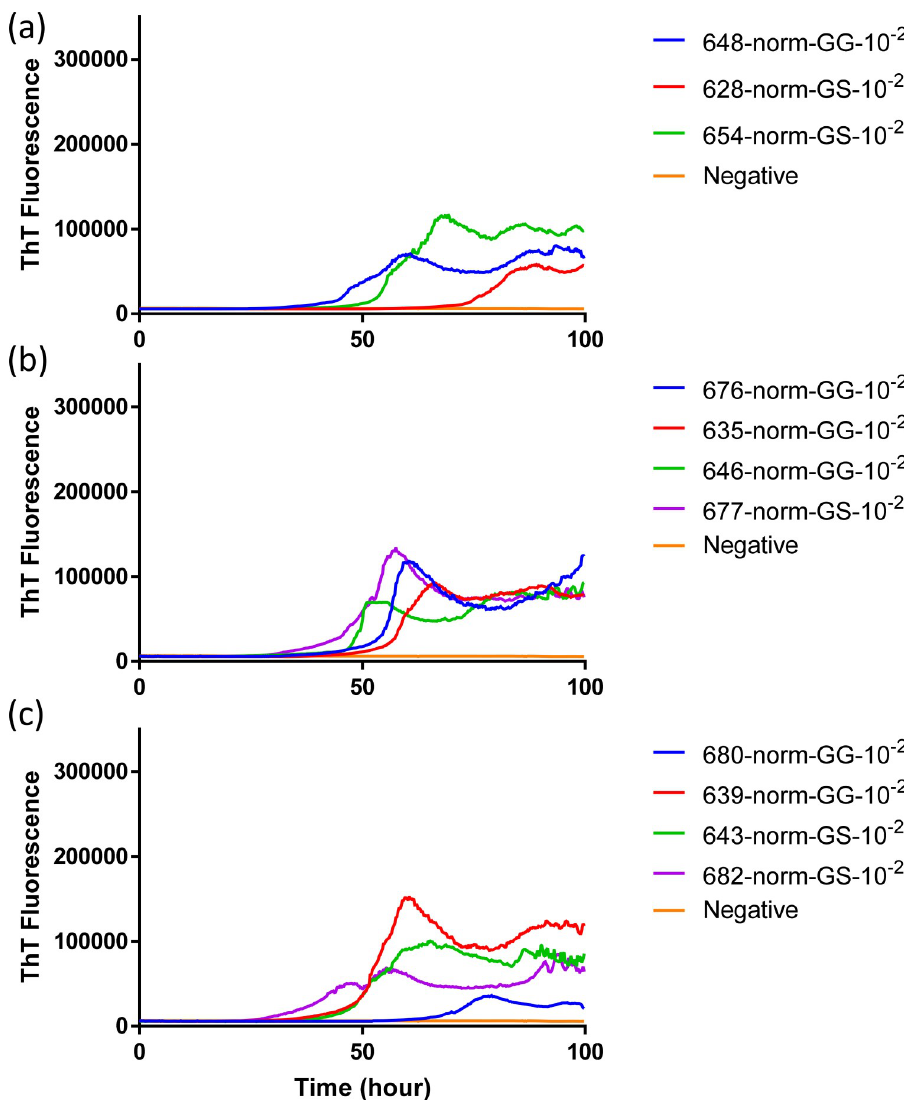
Fig 5. Comparison of seeding activity of RT-QuIC reactions with human rPrP which contain brain seeds from WTD inoculated with brains of infected white-tailed deer (a), elk (b) or mule deer (c) in the presence of 0.001% SDS. This shows RT-QuIC reactions seeded with 10 − 2 dilution of EIA normalized brains. Data are presented as mean ThT fluorescence of 4 repeated reactions. Data are presented as mean ThT fluorescence of 4 repeated reactions. seeded with 10 − 2 of EIA normalized brain tissues from CWD infected reindeer. All assays seeded with positive animals showed ThT fluorescence increase within 20 hours similar to the results reported here for assays seeded with CWD positive white-tailed deer confirming that recombinant human PrP can be useful for rapid detection of CWD prions (Fig 9). In addition, all reaction assays from each CWD source were averaged across genotypes and the result of which are shown in the figure (Fig 10). All reactions had similar lag time and ThT fluorescence intensity as observed with seeded reactions from white-tailed deer which suggests that there is no consistent association between in-vitro seeding activity and genotypes of reindeers or source of CWD inoculum.